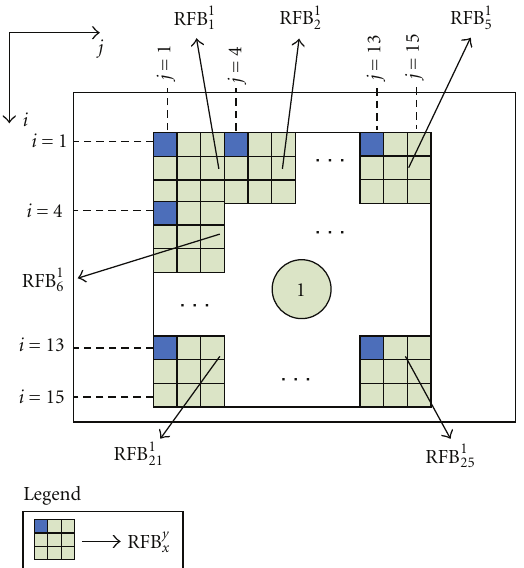
Figure 6: Illustration of reference frame blocks processed during a single control step for p = q = 3 and M = N = 16.